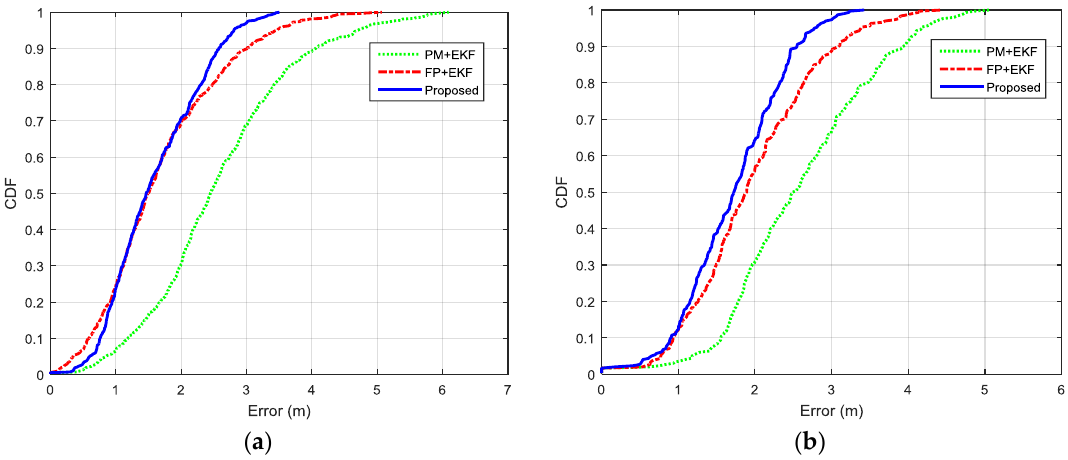
Figure 14. CDFs of localization errors of the two indoor trajectories with densely distributed BLE beacons using the proposed method, PM+EKF, and FP + EKF: ( a ) Trajectory I; and ( b ) Trajectory II. Table 1. Summary of localization errors of two trajectories in the case of dense distribution of BLE beacons (m).